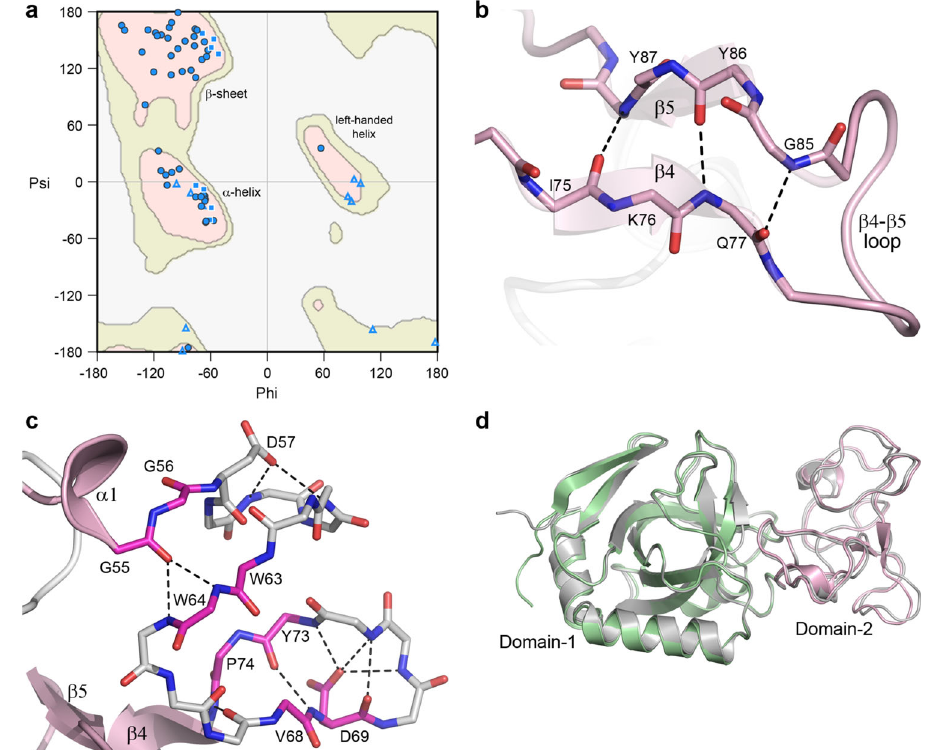
Fig.4|Domain-2structure.a RamachandranplotforDomain-2ofV-Csnapo1.The main chain torsion angles ( phi and psi ) are shown as light blue triangles (glycine), light blue squares (proline) and blue circles (all other residues). The three favored regions for β -sheets, α -helices and left-handed helices are colored pink. The addi- tionally allowed regions are colored pale yellow. b Hydrogen bonding interactions between the two short β -strands, β 4 and β 5, in Domain-2. c Hydrogen bonding interactionsinthe20-residueregioninDomain-2betweenhelix α 1(a3 10 helix)and strand β 5 (shown as gray sticks for main chain atoms only). This region contains